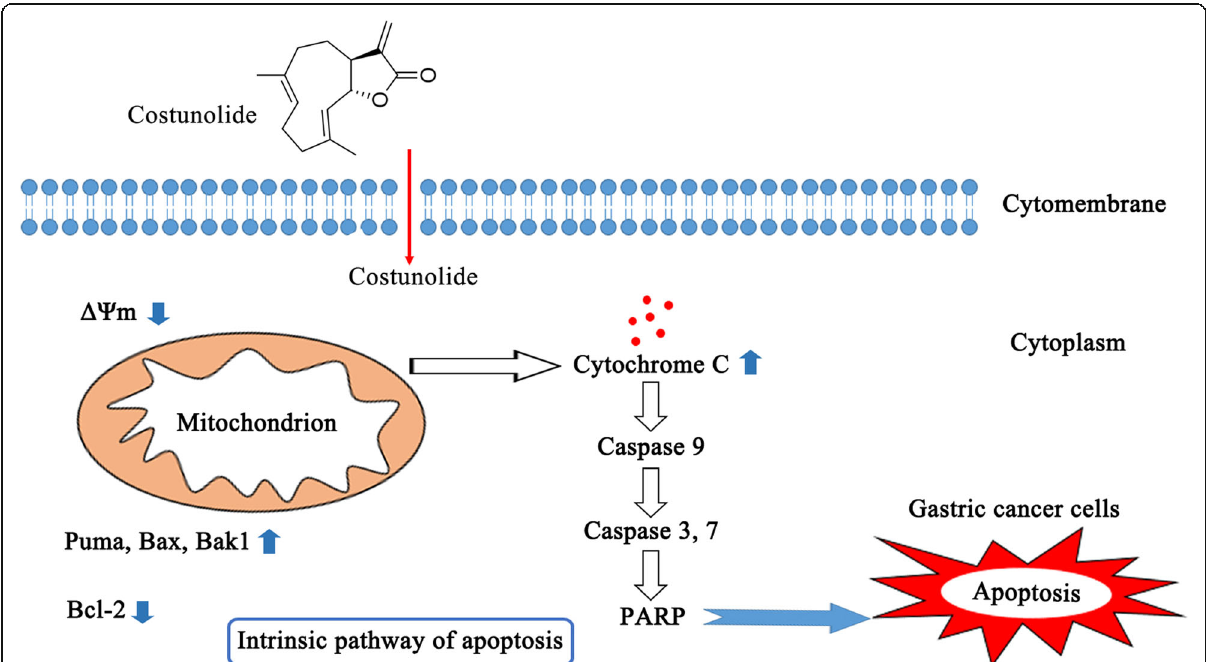
Fig. 5 Mechanisms of mitochondria-mediated apoptosis induced by costunolide in human gastric adenocarcinoma BGC-823